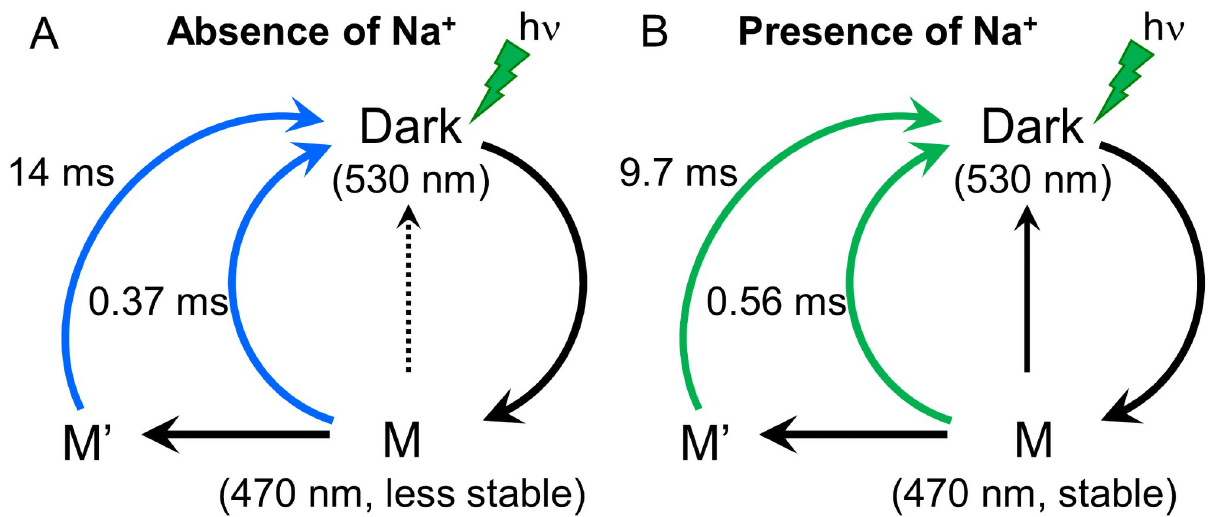
Fig 7. Reaction scheme of the photo/transport cycle of KR2. A, The cycle is initiated by green light absorption of the Dark state to form M- intermediate. The M-intermediate decays in to the dark state with a time constant of 14 ms ( τ off LED ). KR2 transport H + indicated in blue arrows. Blue light illumination triggers a photoisomerization of M-intermediate, which result in a no-transport cycle indicated in a dotted line. B, Similar cycle can be proposed for Na + transport with time constant of 9.7 ms ( τ off LED ). The no-pump cycle by blue light (black arrow) is favored in the presence of Na + compared to the absence of Na + , because M-intermediate is more stable according to the result in Fig